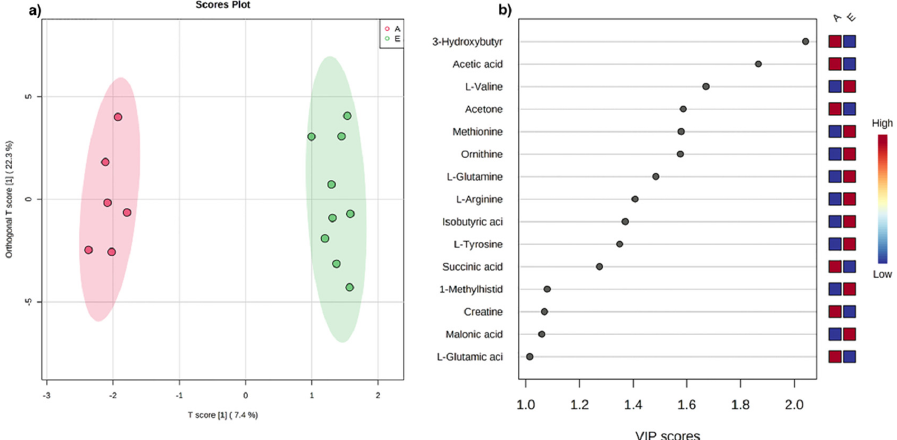
Figure 1. ( a ) O-PLS-DA score plot for 1 H NMR data collected in 1D-NOESY spectra acquired at 600 MHz. Data represent the sera from 9 early (green) and 6 advanced (red) ALS patients. ( b ) VIP score analysis derived from O-PLS-DA. Color code indicates higher (red) or lower (blue) concentrations in early (E) compared to advanced (A) ALS patients.